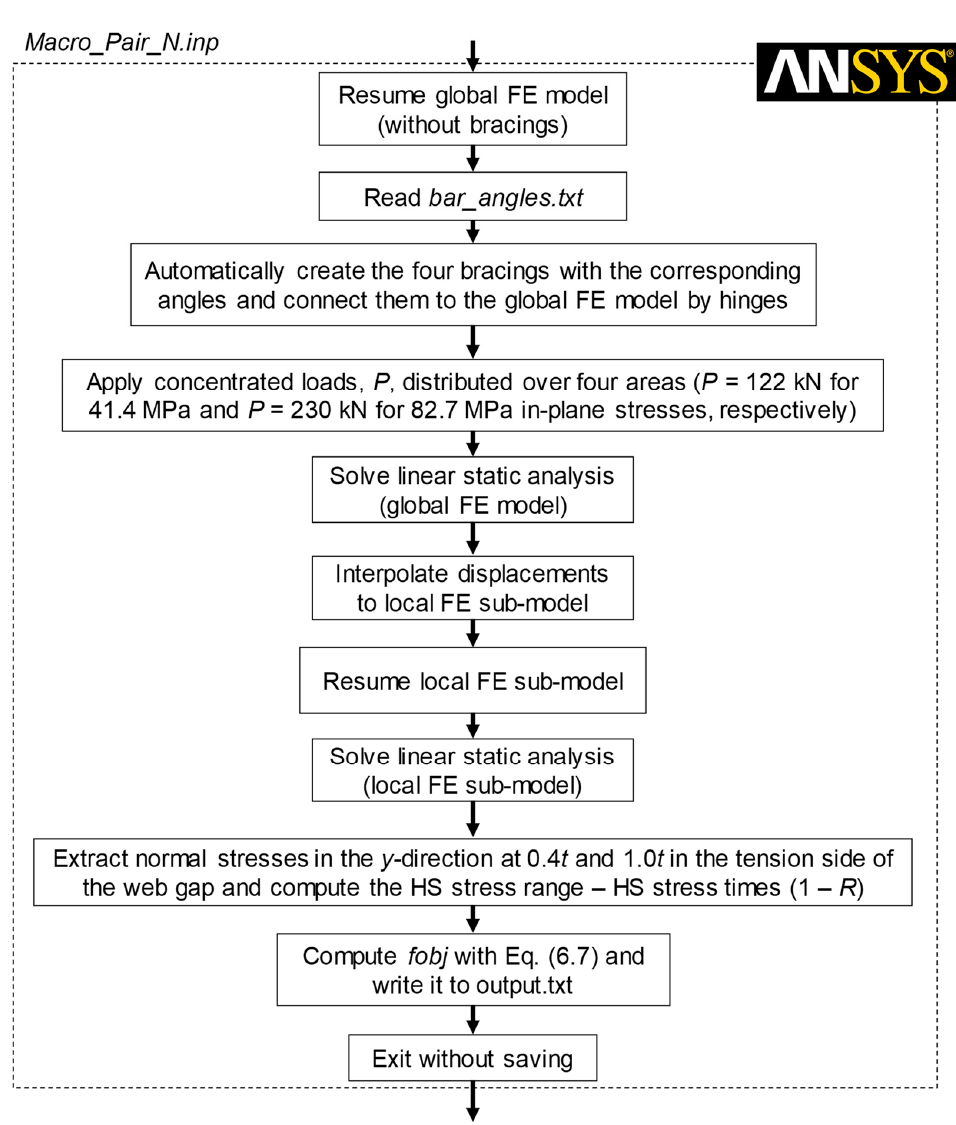
Figure 11. Flowchart for the calibration procedure of web gap test setup: ANSYS Macro.